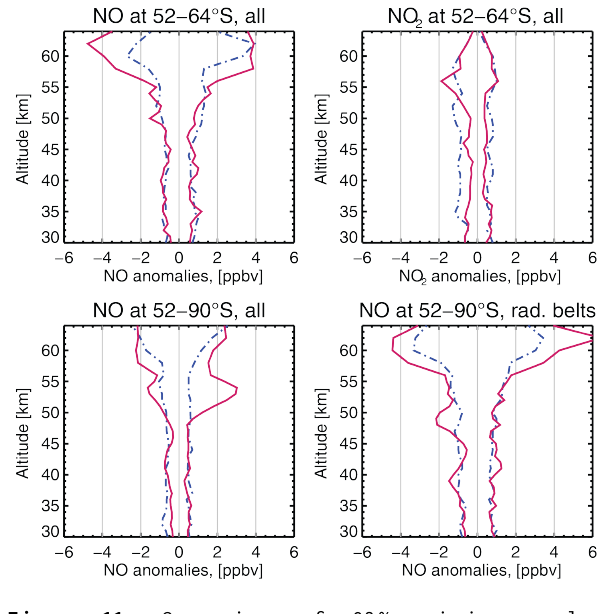
Figure 11. Comparison of 98% significance level for days with low electron fluxes (blue dashed lines, ≤ 2 × 10 4 electronscm − 2 s − 1 sr − 1 of the 100–300keV pre- cipitating electrons) with maximal and minimal anomalies of NO 2 and NO (red lines) on days of enhanced electron fluxes ( ≥ 2 × 10 4 electronscm − 2 s − 1 sr − 1 of the 100–300keV precip- itating electrons) as a function of altitude. Upper left: daytime NO at 52–64 ◦ S, all geomagnetic latitudes. Upper right: nighttime NO 2 sampled over the same area. Lower left: daytime NO at 52–90 ◦ S, all geomagnetic latitudes, and lower right: daytime NO at 52–90 ◦ S, geomagnetic latitudes corresponding to the radiation belts (55–68 ◦ ). The period of largest proton forcing (27 October–6 November) is